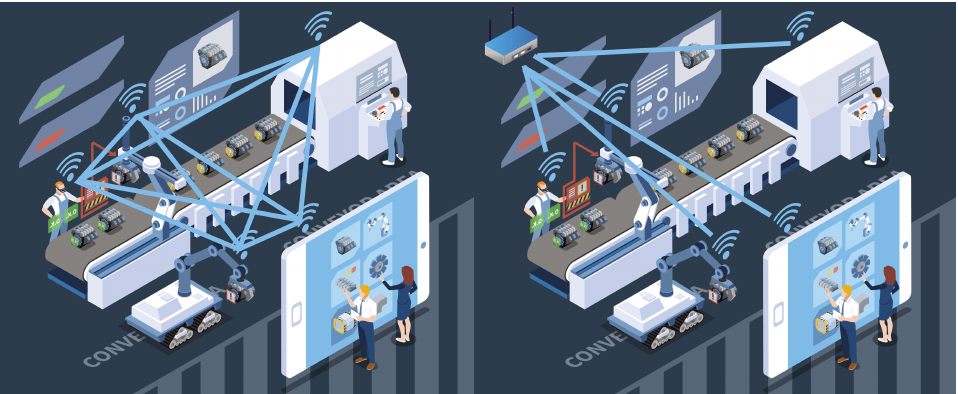
Figure 10. Network architectures for industrial applications [105]. The adapted image denotes the meshed ( left ) and star ( right ) topology which can be utilized, depending on the production